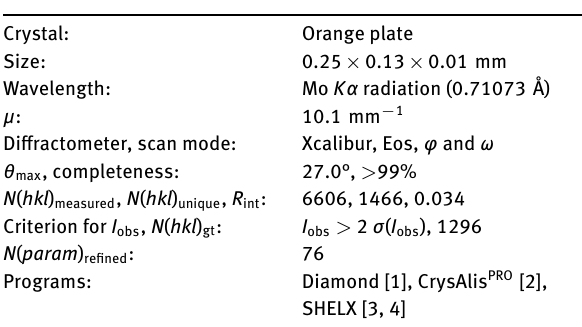
Table 1: Data collection and